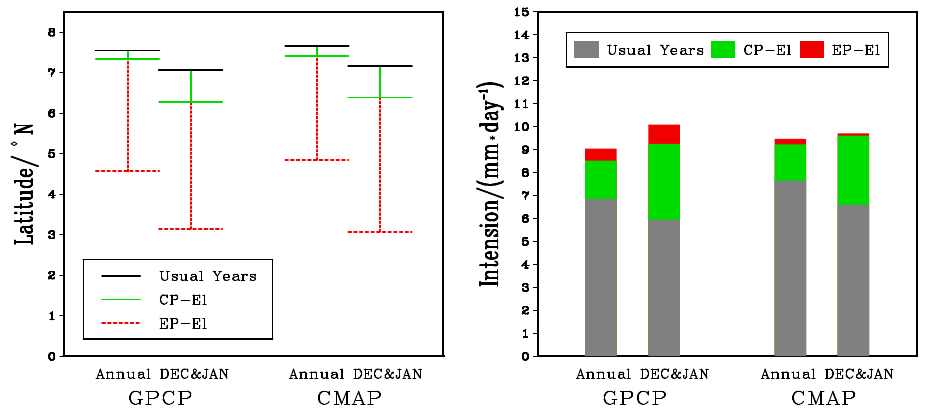
Figure 2. The annual mean mffset of CEP-ITCZ position (Left) and intensity (Right) in two types of El Niño years and the Offset during the mature period of El Niño.